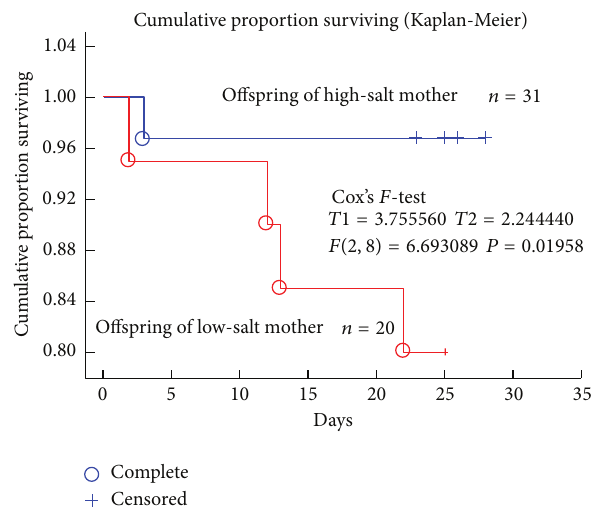
Figure 2: Cumulative proportion of offspring survival (Kaplan- Meier analysis). Survival prognosis was evaluated from their birth of the rat pups to weaning. Blue circles refer to the death (complete) of pups from high-salt intake mothers; red circles refer to the death (complete) of pups from a low-salt intake mothers. Plus (+), censor. ThedifferencewasanalyzedbyCox’s 𝐹 -test( 𝑇1 = 3.755 , 𝑇2 = 2.244 , 𝐹(2,8) = 6.6930 , and 𝑃 = 0.01958